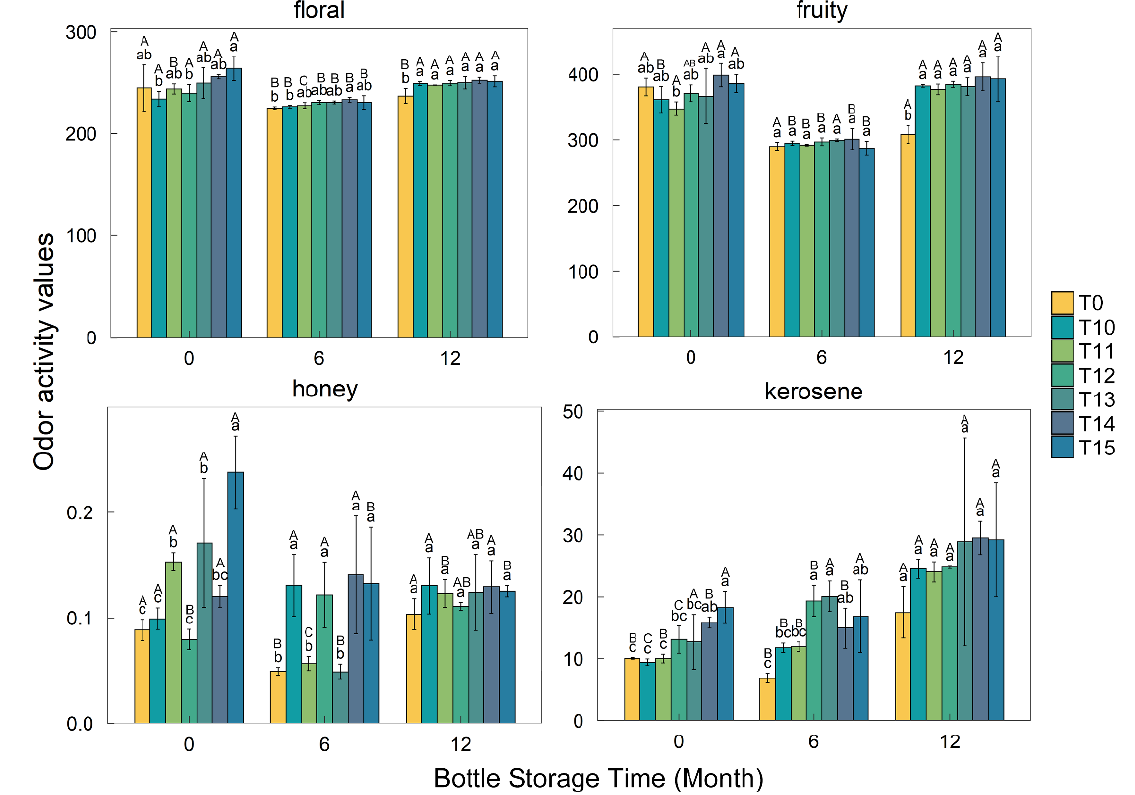
Figure 4. Effect of cold treatment duration on the OAVs of four aroma types (floral, fruity, honey, and kerosene). Samples ( n = 3). Different lowercase letters represent significant differences in the OAV between different groups at the same bottle-storage period. Different capital letters represent significant differences in the OAV between different bottle-storage durations for the same treatment group (Duncan, p < 0.05).